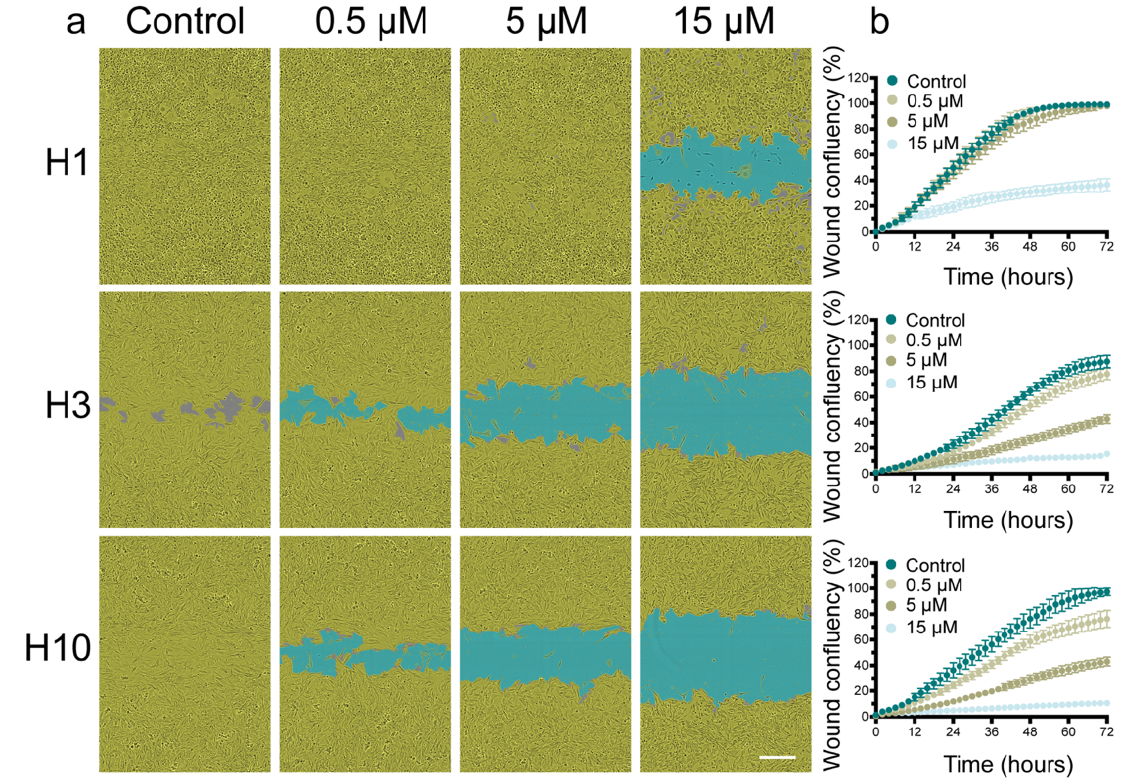
Figure 3. Cabozantinib inhibits the migration of MBM cell lines. ( a ) Representative phase-contrast images (10 × objective) showing the wound confluency obtained 72 h after a scratch wound. Cells were treated with cabozantinib (0.5 µ M, 5 µ M or 15 µ M) or left untreated (control). The MBM cells are colored in yellow and the scratch wound is colored in blue. Scale bar = 300 µ m. ( b ) Representative graphs showing the wound confluency over a time period of 72